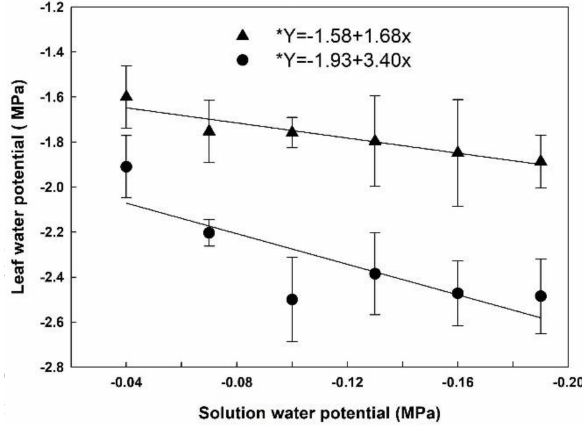
Figure 3. Leaf water potential at 13:00 in rice plants grown at different solutions with different water potentials. The error bars represent the standard error. * p -value < 0.05; • = HET; (cid:78) = LET.